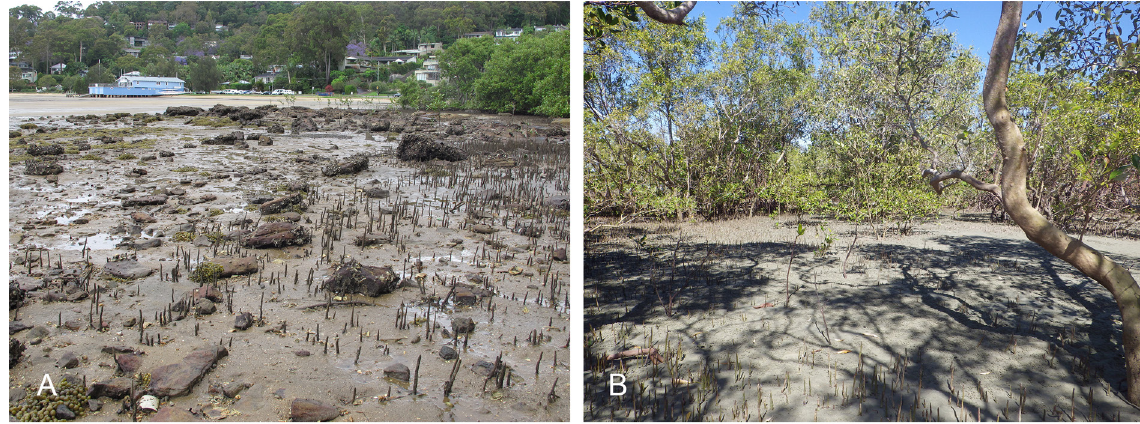
Fig. 30. Paromoionchis daemelii (Semper, 1880) comb. nov., habitats. A . Australia, New South Wales, muddy sand next to small patch of mangrove and rocks on sandy beach (station 39). B . Australia, Queensland, Rhizophora and Avicennia mangrove (station